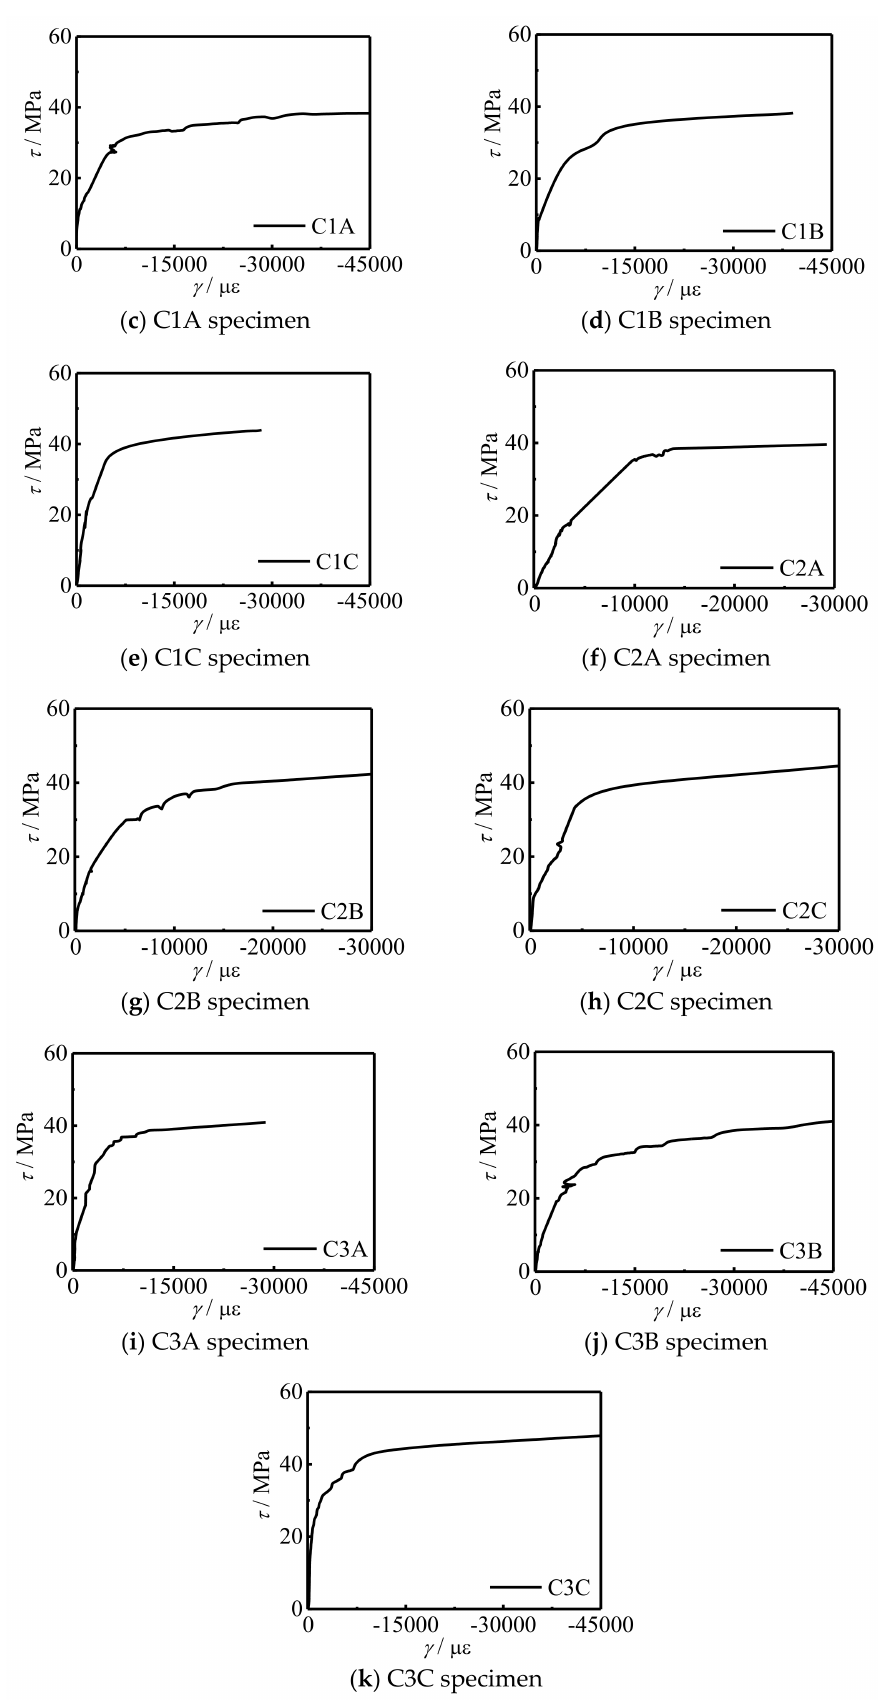
Figure 7. τ - γ curves of